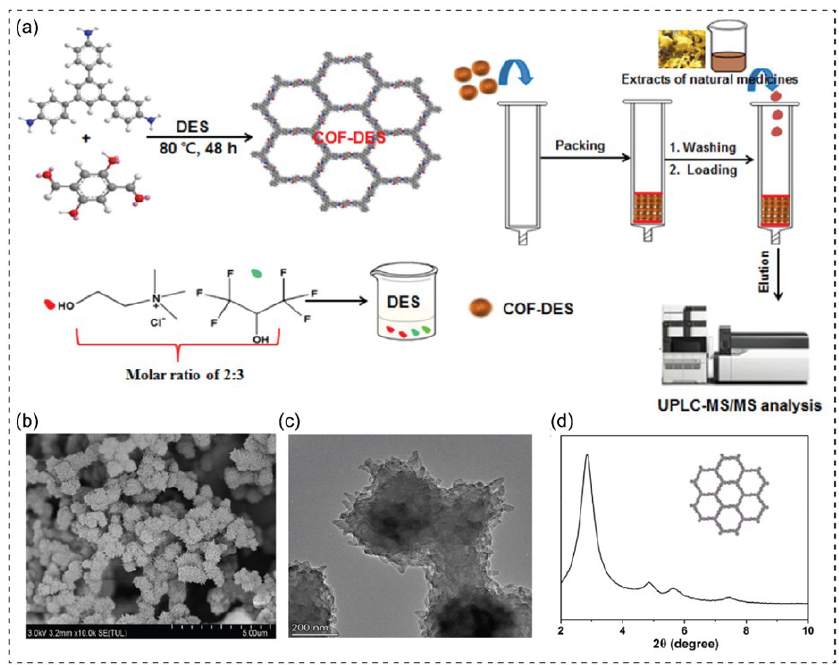
Figure 3. ( a ) The design and application of deep eutectic solvents (DESs) as a reaction solvent for fabricating high crystallinity COF-DES. ( b ) SEM image, ( c ) TEM image, and ( d ) PXRD pattern of as-prepared COF-DES. Reprinted with permission from ref. [108]. Copyright 2021 American Chemical Society.